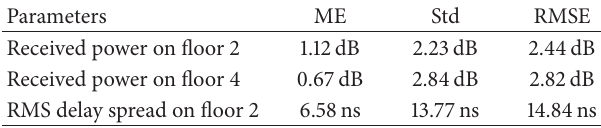
Table 3: The difference between the measurement and the ray- optical model.